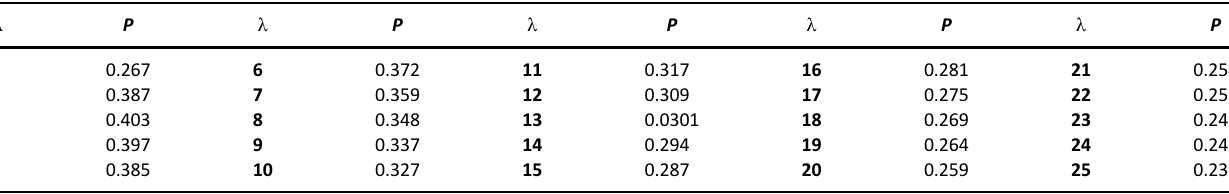
Table 1. Partial MidProb